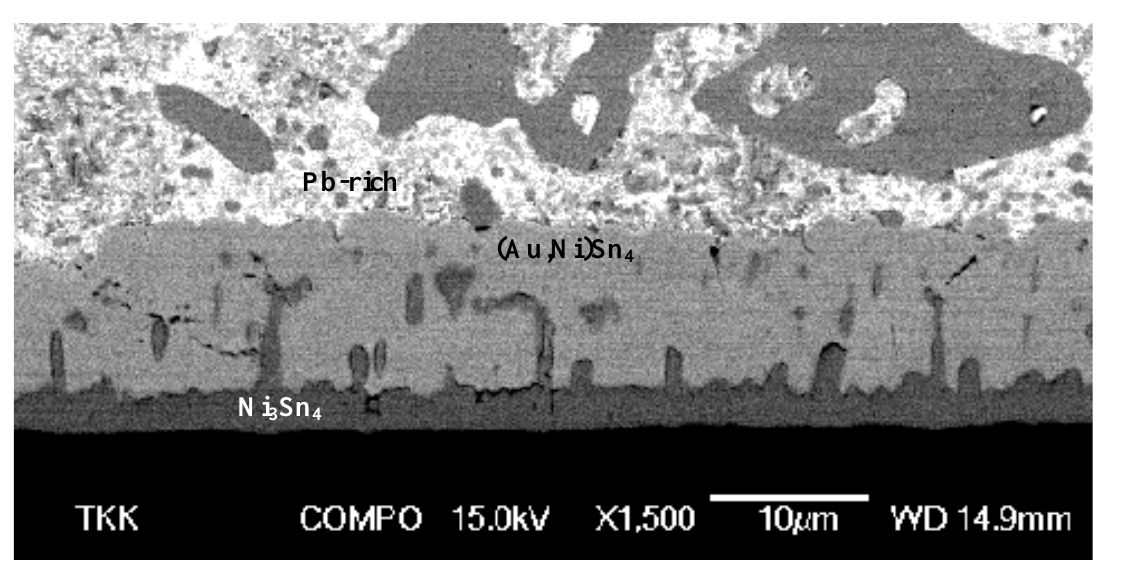
Figure 14. SEM micrograph from the (SnPbAg)/Ni/Au system after annealing for 250 hours at 150